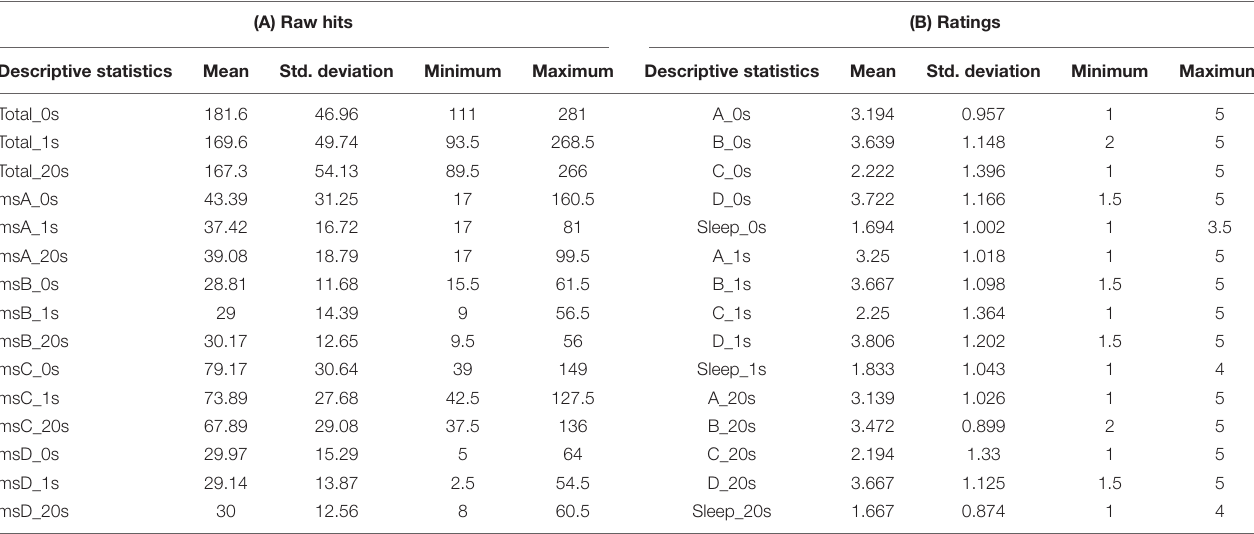
FIGURE 6 | Questionnaire ratings for controllability and the raw number of Hits. (A) Participants reported their subjective feelings regarding “controllability” over the targeted EEGms and their sleepiness on the five-point Likert scale. (B) Participants’ raw Hits performance for each EEGms target. (C) A plot between the number of raw Hits and the Likert rating, including the delay conditions. Error bars indicate ± SE. TABLE 1 | Descriptive statistics for participants’ raw Hits and